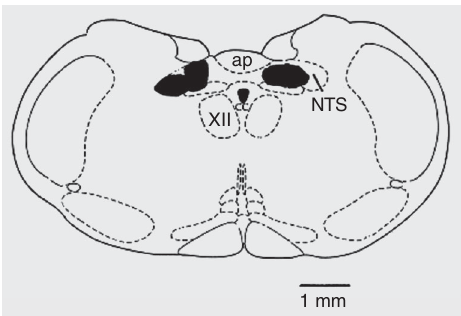
Figure 1. Schematic representation of a coronal sec- tion of a rat brain stem showing the sites of bilateral injections in the nucleus tractus solitarii (NTS). ap = area postrema; XII = hypoglossal nucleus; cc = central canal.